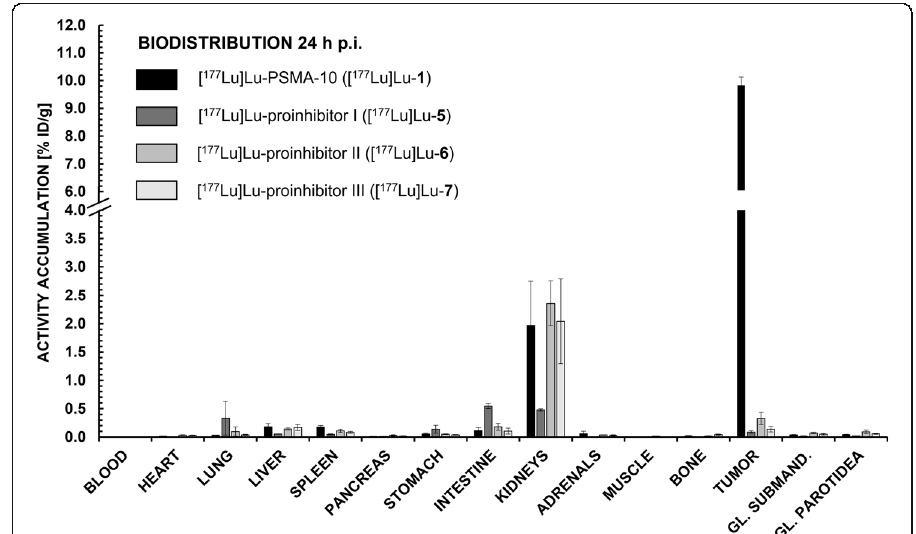
Fig. 3 Biodistribution data (% ID/g) of [ 177 Lu]Lu-PSMA-10 ([ 177 Lu]Lu- 1 ), [ 177 Lu]Lu- 5 , [ 177 Lu]Lu- 6 and [ 177 Lu]Lu- 7 in tumor xenograft-bearing CB17-SCID mice at 24 h p.i. ( n = 2 for [ 177 Lu]Lu- 5* , n = 3 for [ 177 Lu]Lu- 6 and [ 177 Lu]Lu- 7 and n = 5 for [ 177 Lu]Lu-PSMA-10 ([ 177 Lu]Lu- 1 )). Submandibular and parotid glands were dissected separately and their values are depicted in the columns ‚ GL. SUBMAND. ‘ and ‚ GL. PAROTIDEA ‘ , respectively. *Ingestion of radioactively contaminated animal feed led to putative high activities in stomach and intestine, therefore excluding all values of mouse 3